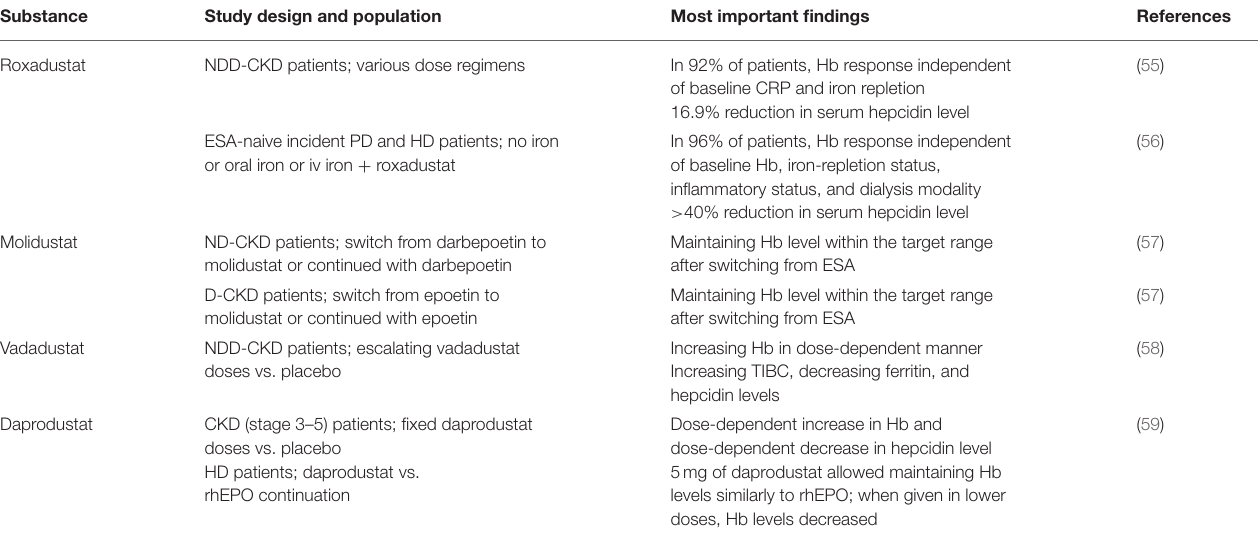
TABLE 1 | The main results of selected trials with HIF-PHIs in CKD